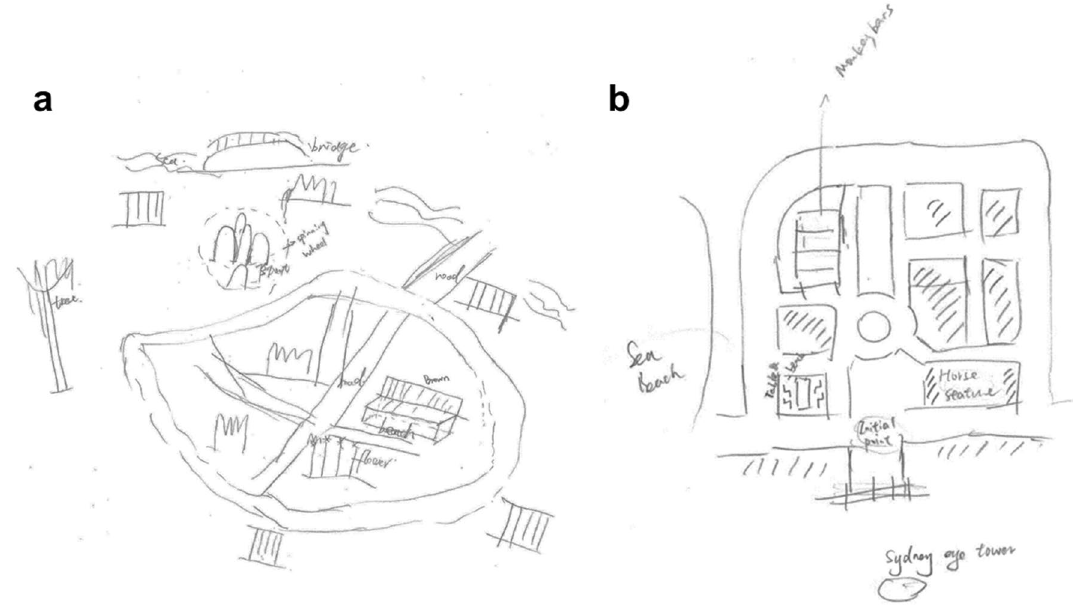
Figure 8. Sketch maps from participants. (a) An example of sketch maps from NVGL group. (b) An example 453 of sketch maps from VGL group.